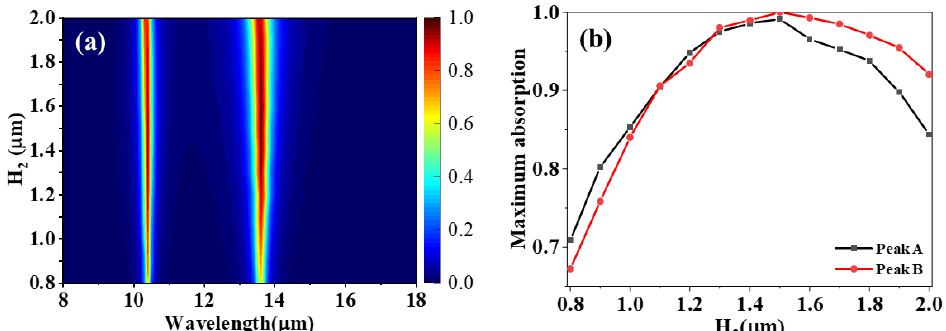
Figure 4. ( a ) The absorption spectra of the designed absorber and ( b ) the maximum absorption of two absorption peaks as a function of H 2 .